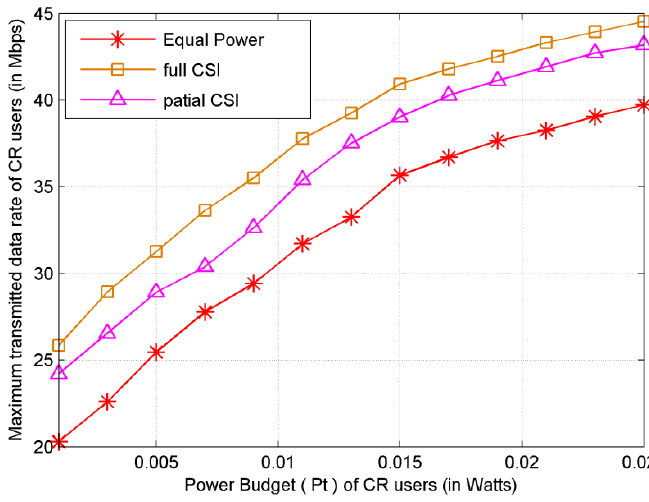
Figure 8. Power Budget versus sum transmitted data rate.